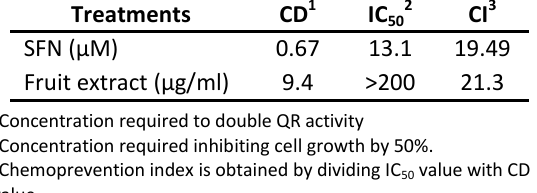
Table 1. Effect of the fruit extract on QR activity